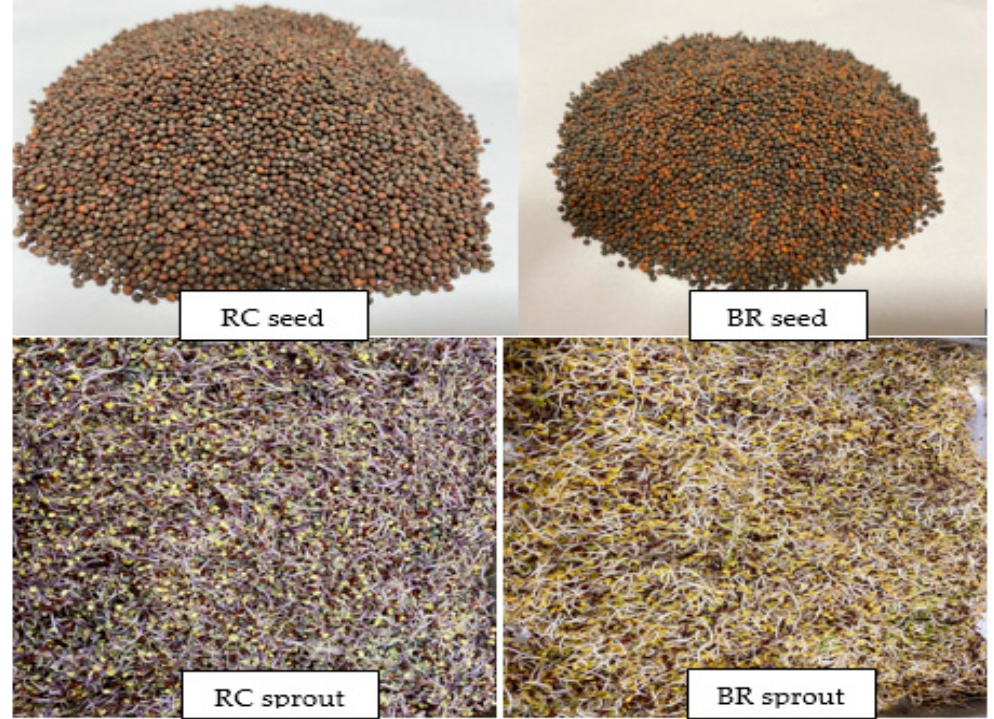
Figure 1. Pictures of raw seeds and sprouts provided by Charm-Chae-One, Ltd. (Jincheon, Chungbuk, Korea). RC, red cabbage; BR, broccoli .